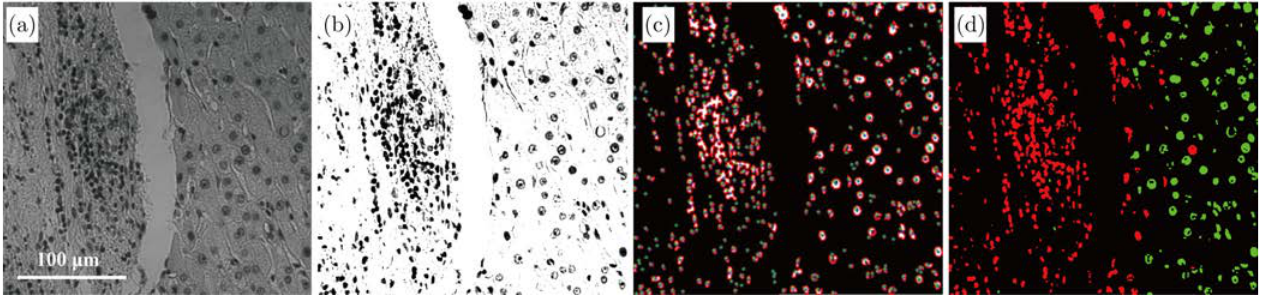
Fig. 7. Automatic classi¯cation of normal and cancer cells. (a) Single-band image for wavelength of 580 nm. (b) Single-band image for wavelength of 580 nm after contrast enhancement. (c) Post-binarization image. Selected points in each nucleus are labeled in green and blue. (d) Pseudocolor image after classi¯cation. Nuclei of normal and cancer cells are labeled in green and red,